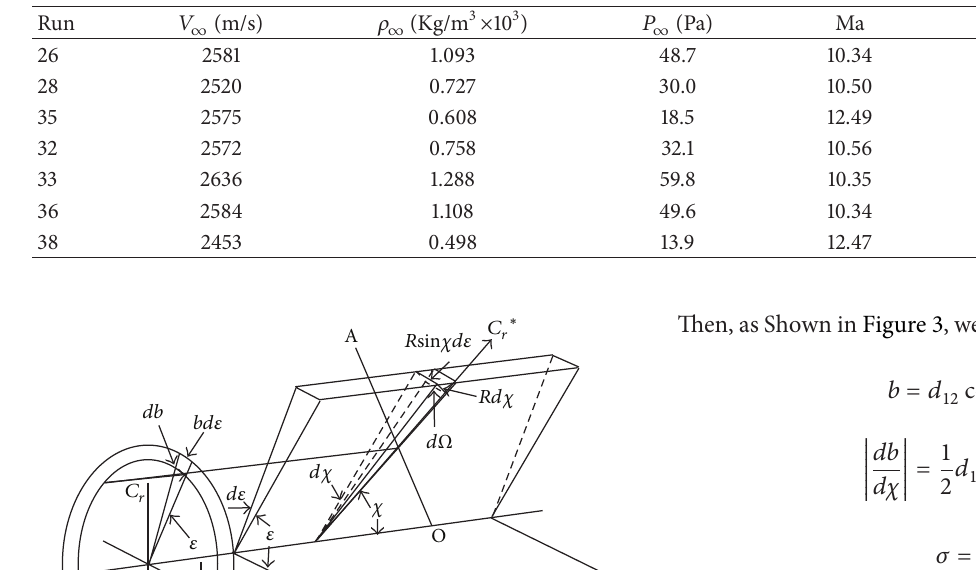
Table 1: Test case in [1].